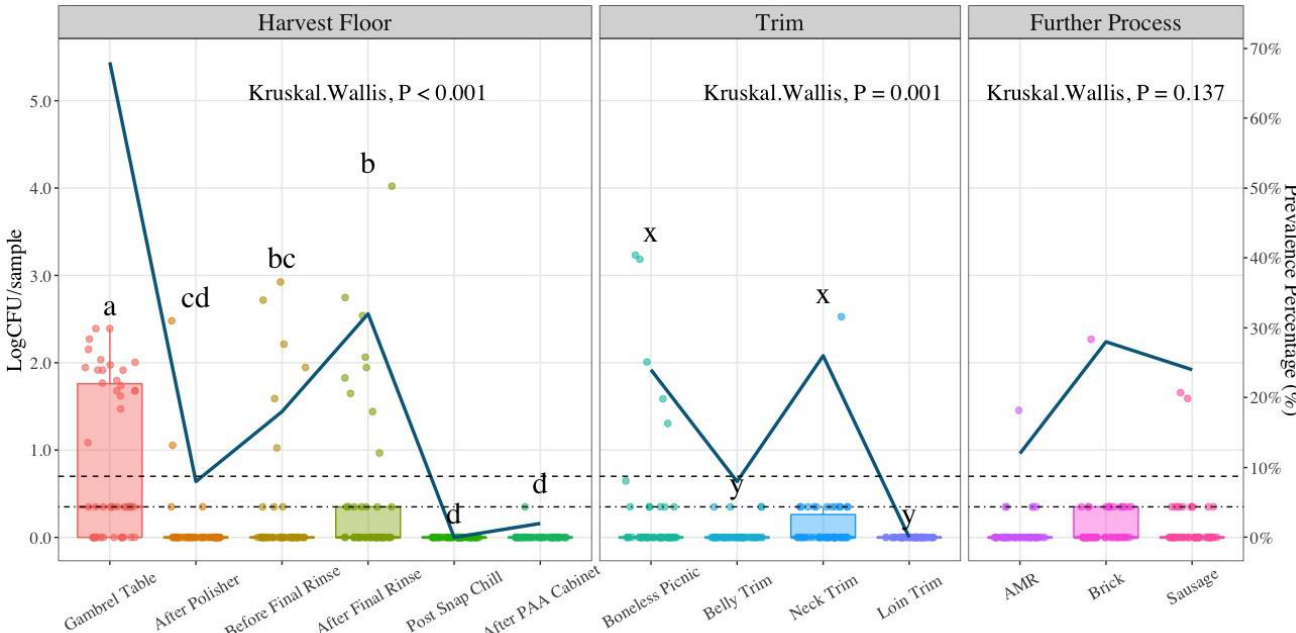
Figure 5. Salmonella counts (LogCFU/sample), left Y axis, and prevalence (solid blue line), right Y axis, at each processing stage throughout the pork processing line. In the boxplot, the horizontal line crossing the box represents the median, the top and bottom lines represent the lower (0.25) and upper (0.75) quartiles, the vertical top lines represent 1.5 times the interquartile range and the vertical bottom line represents 1.5 times the lower interquartile range. The dots represent actual data points. The LOQ for SalQuant™ on pork carcass swabs is 1 CFU/mL. The LOQ for SalQuant™ on pork trim and ground pork is 1 CFU/g. The new LOQ is represented by the dashed line. The new LOD is represented by the dot-dash line. This LOD applies for samples that were Quant Negative but positive after prevalence testing. Box plots with different letters (a – d); (x – y) represent statistical significant differences according to Kruskal – Wallis analysis followed by pairwise comparison with Wilcoxon’s test at p -value < 0.05. PAA (Peroxyacetic acid); AMR (Advanced Meat Recovery) .